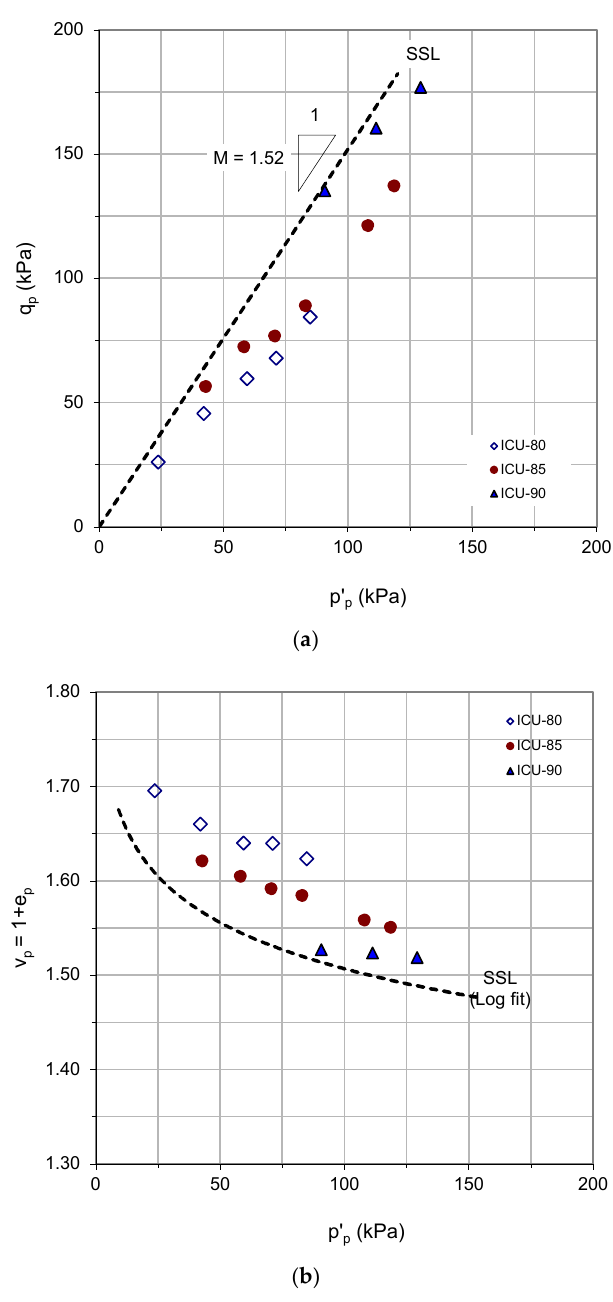
(cid:48) − q p ; ( b ) p (cid:48) − v p p p